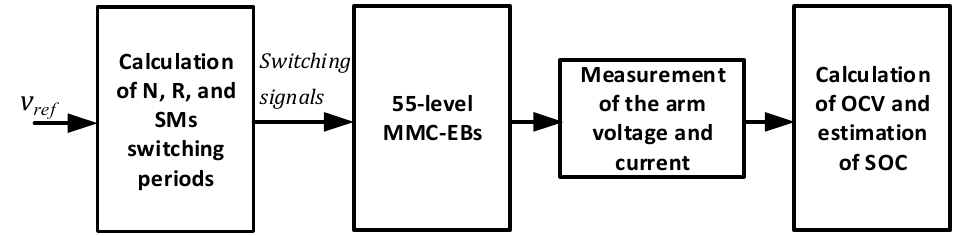
Figure 14. Block diagram of the proposed SOC estimation method.